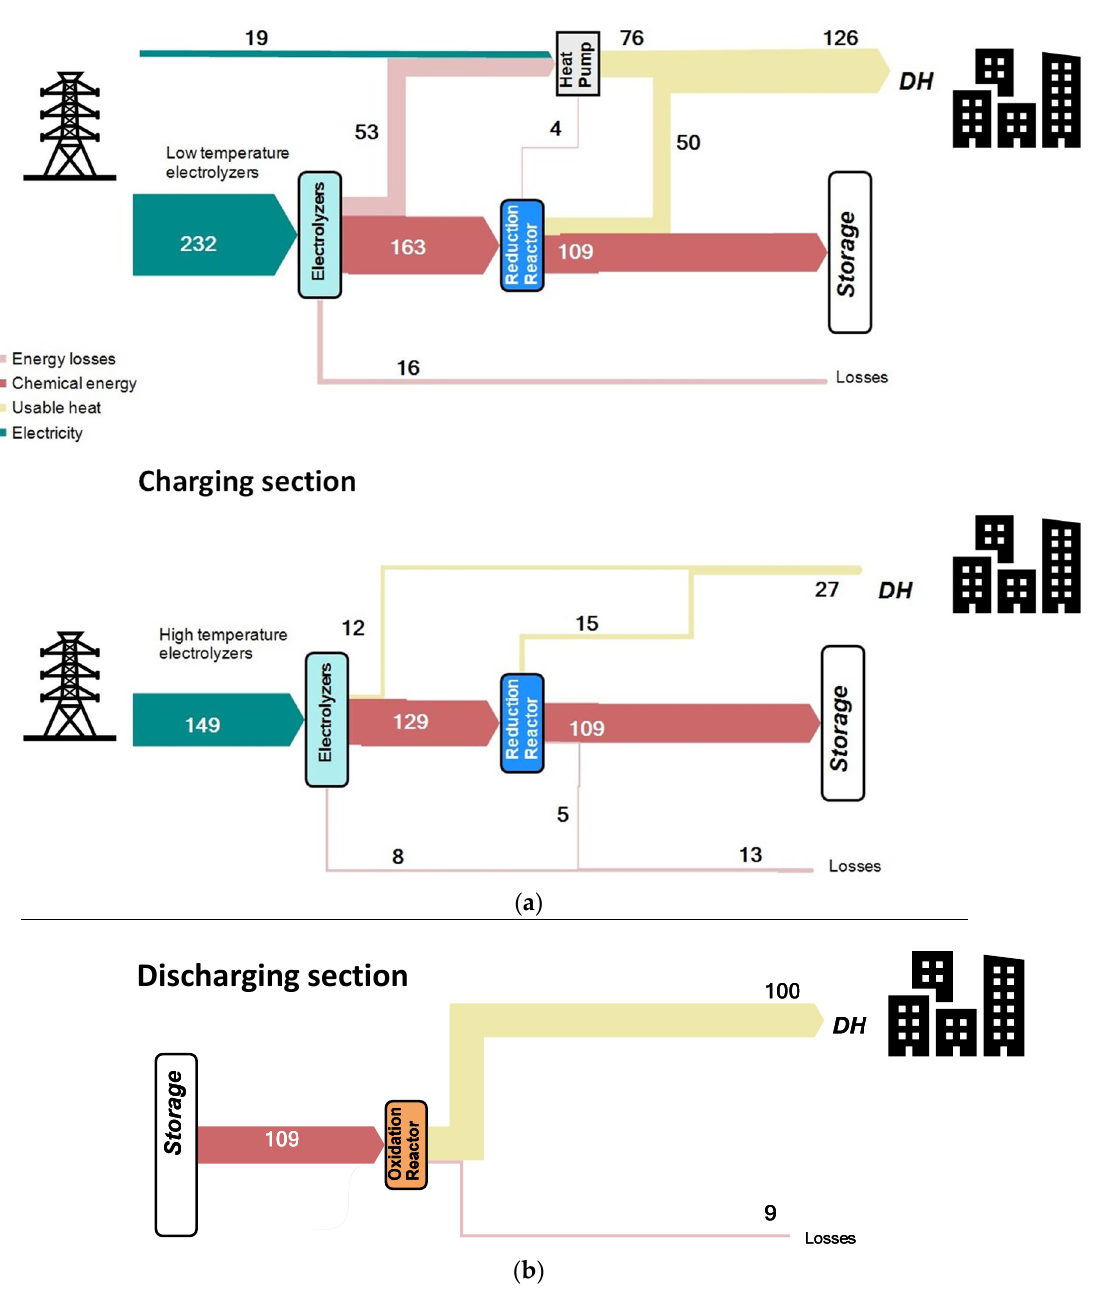
Figure 7. Overall energy flows of the proposed scheme for both the low-temperature electrolyzers case and the high-temperature electrolyzers case, normalized for 100 energy units of dispatchable DH production (i.e., generated in the discharging section). Note that the discharging section in the case with high-temperature electrolyzers is the same as that in the case with low-temperature electrolyzers and, therefore, is not included ( a ) Energy flow of the charging section for the schemes with low-temperature electrolyzers (top) and with high-temperature electrolyzers (bottom) ( b ) Energy flow of the discharging section (does not differ between the two